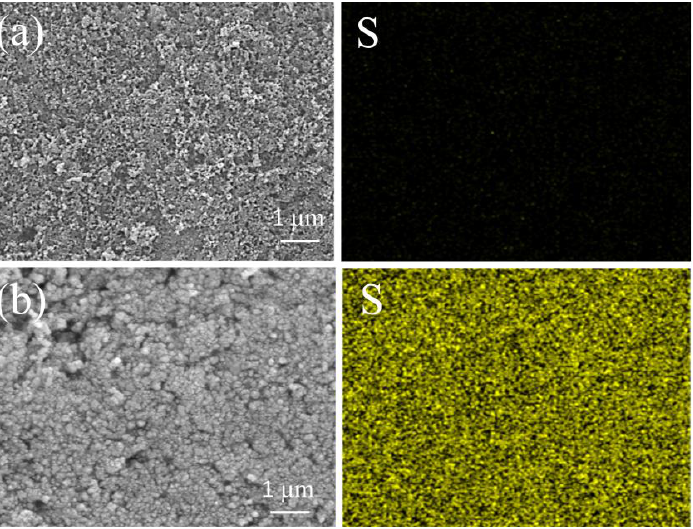
Figure 5. ( a , b ) SEM and EDS images of the BKT separator before and after 100 cycles at 0.1 C current density, respectively.